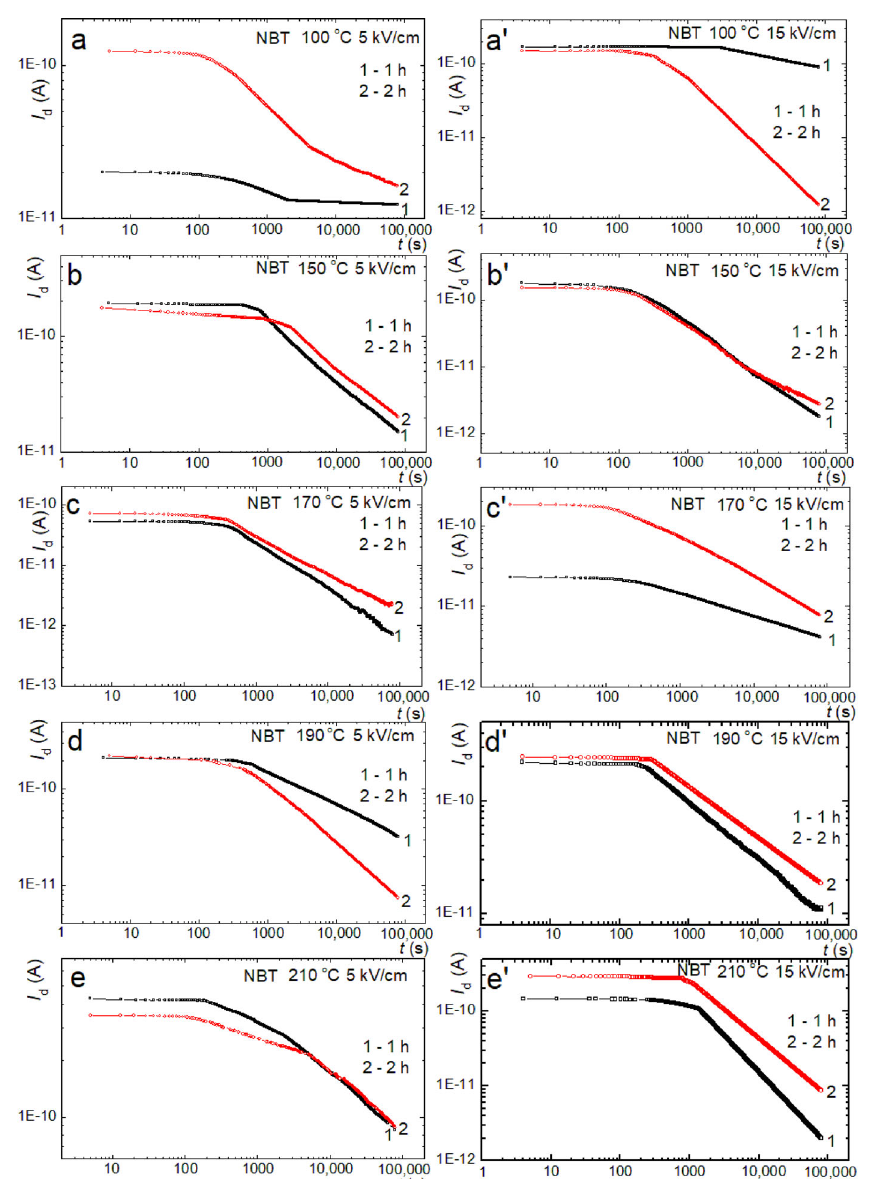
Fig. 4 Depolarization currents of NBT ceramics measured after applying an electric field of either (a–e) 5 kV/cm or (a ʹ –e ʹ ) 15 kV/cm for 1 and 2 h and at different temperatures. Note that both axes utilize a log